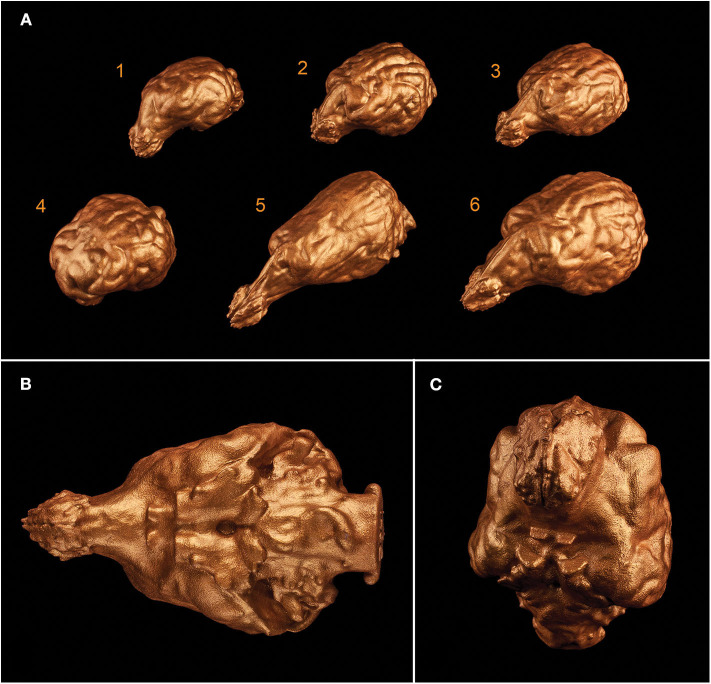
3D prints of different endocasts. (A) Endocast of a Welsh terrier (1), a border collie (2), a Weimaraner (3), a pug (4), a borzoi (5), and a gray wolf (6). (B) Ventral aspect of the endocast of a Weimaraner. (C) Rostroventral aspect of the endocast of a border collie.